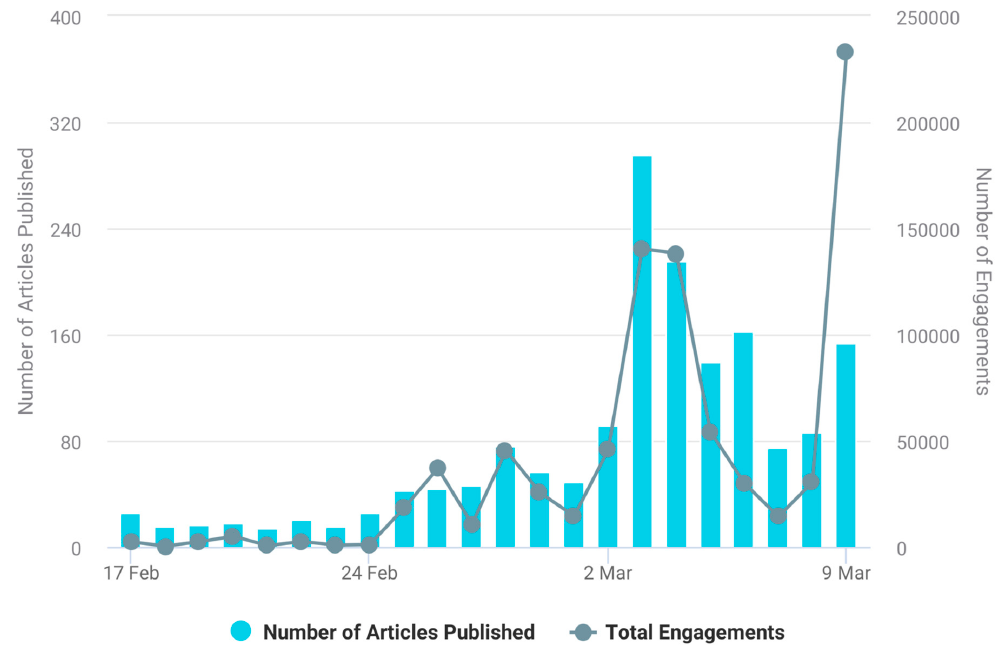
Figure 5. Number of Articles Published Mentioning Coronavirus “Stockpiling” (Source: Brandwatch Consumer Research,